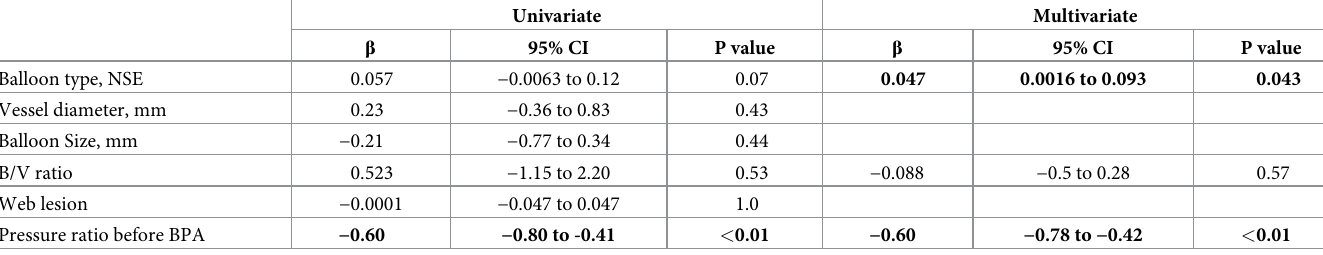
Table 6. Univariate and multivariable analysis of Δ Pressure ratio in B/V ratio > 1.0 (n =